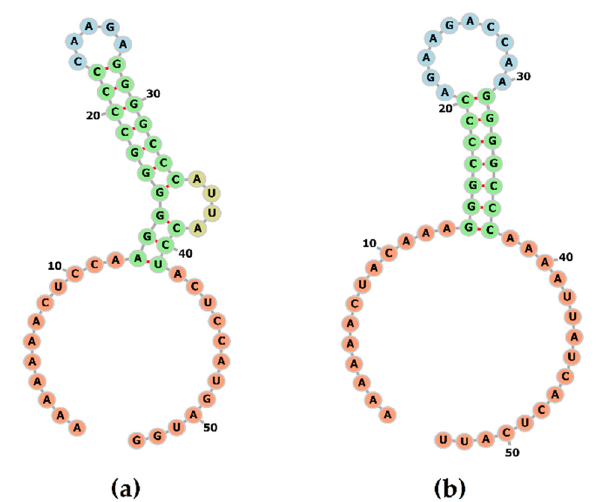
Figure 3. Secondary structure of the frameshift signal of PoAstV3 ( a ). The structure is composed of a stem motif with a conserved loop and bulge. The secondary structure of the frameshift signal of human astrovirus 2 (GenBank accession L13745) was modeled for comparison ( b ).